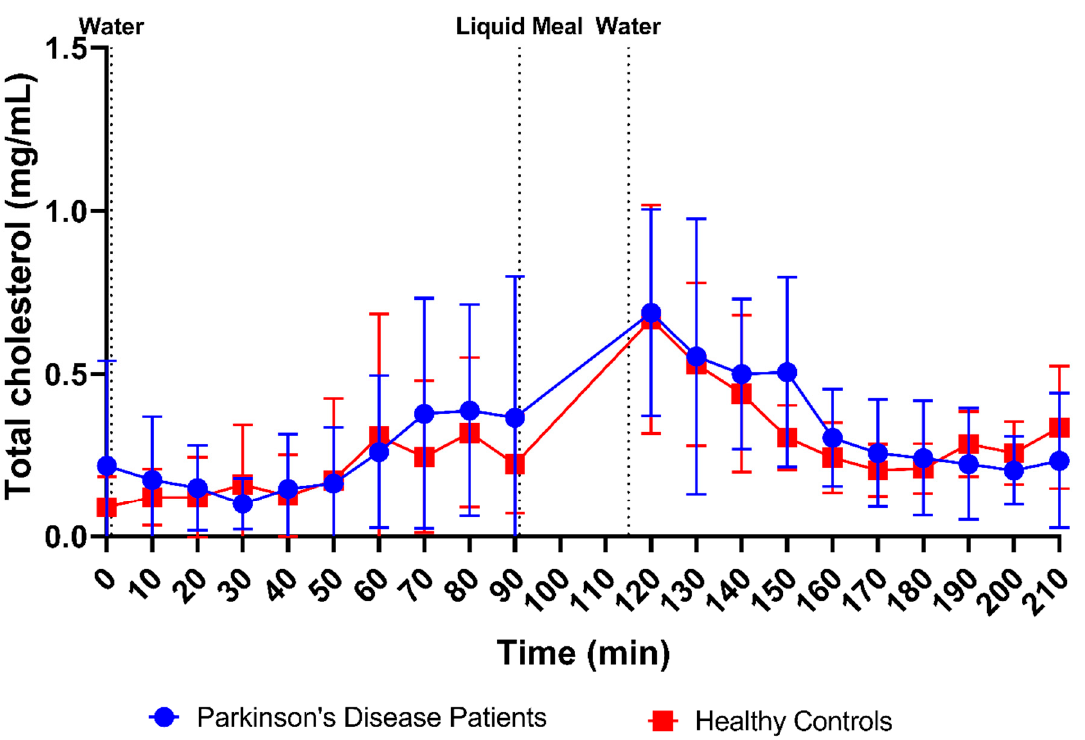
Figure 12. Time-dependent evolution of the total cholesterol concentration in duodenal fluids aspirated from Parkinson’s disease patients ( n = 9, blue circles) and healthy controls ( n = 9, red squares). Each data point represents the mean ± standard deviation; the vertical dotted lines indicate the ingestion of 100 mL of water or 200 mL of liquid meal.